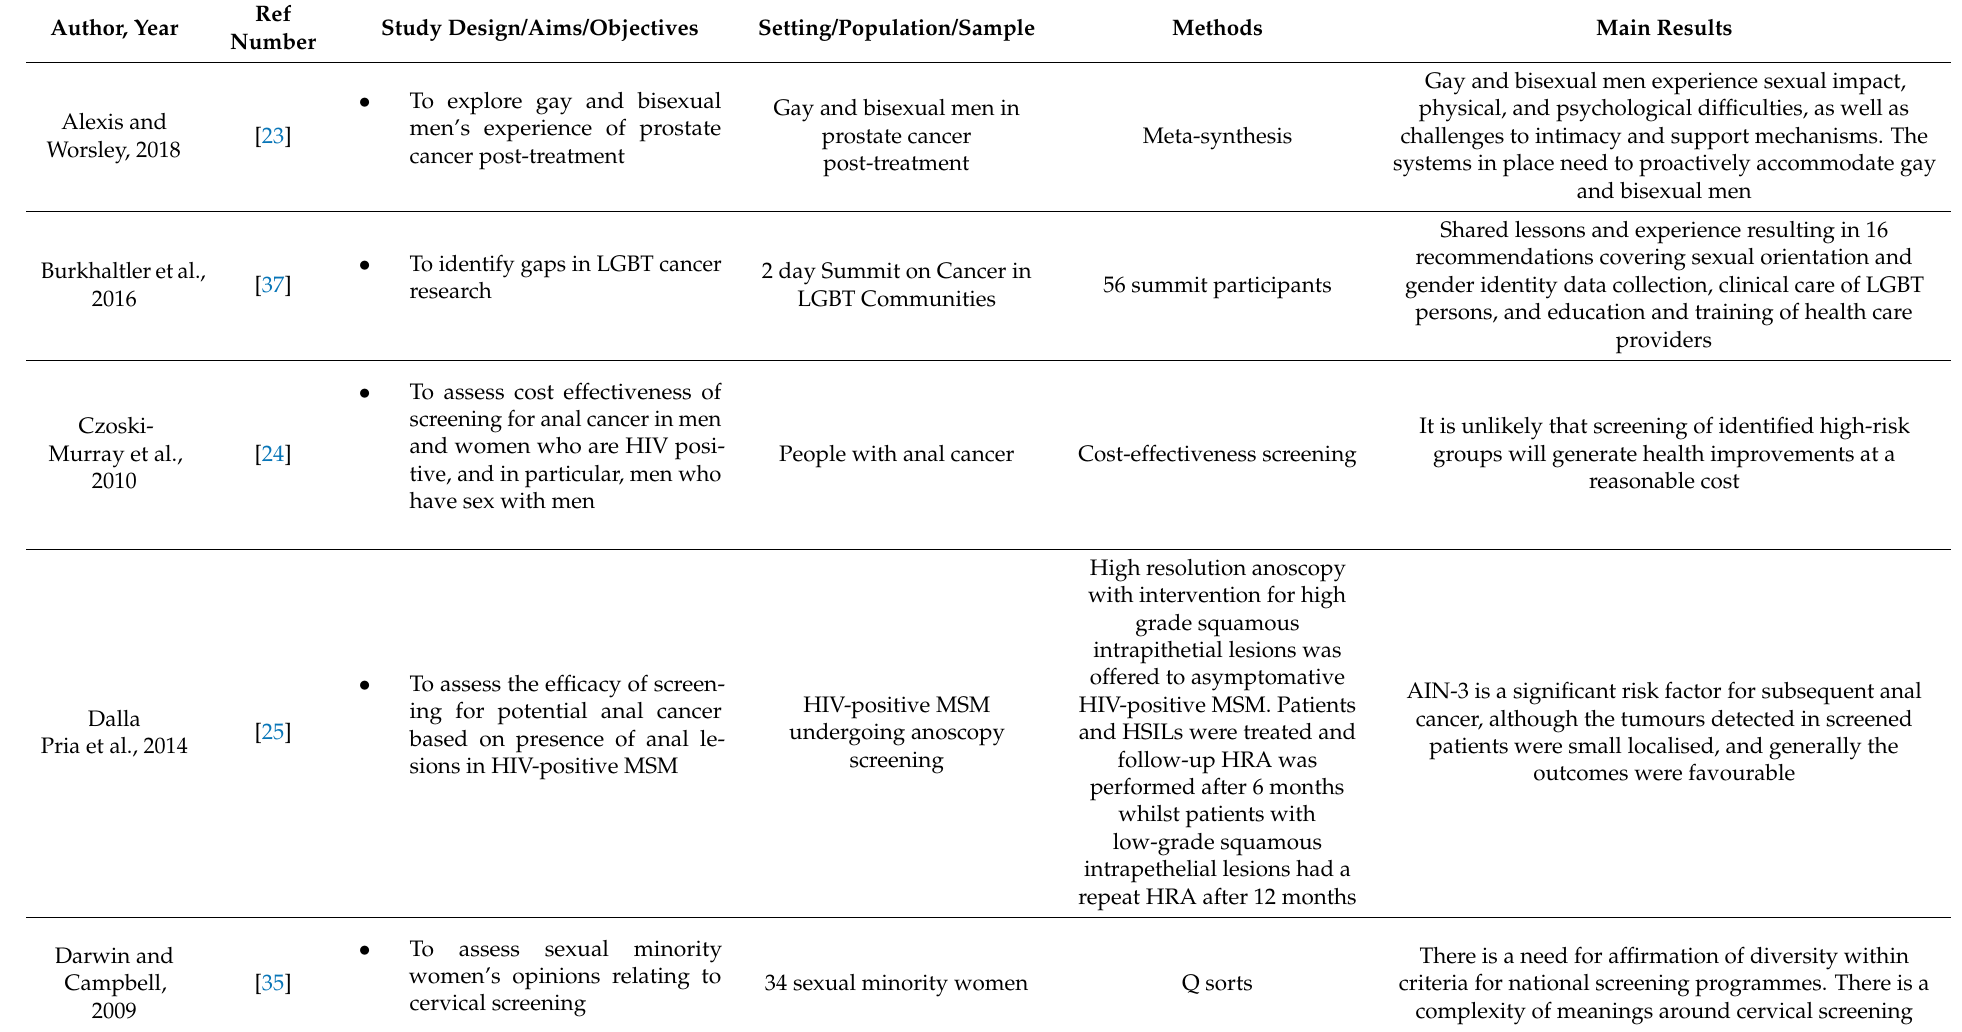
Table A2. UK Cancer and LGBT+